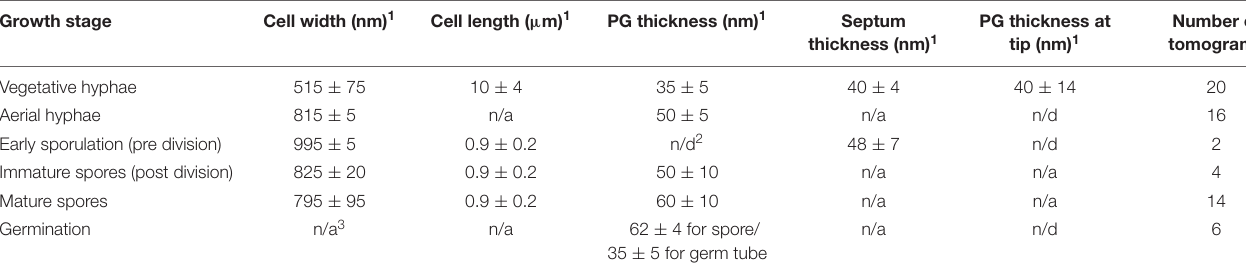
FIGURE 2 | Cryo-ET of vegetative, sporulating, and germinating Streptomyces . Tomographic slices through S . albus at different growth stages corresponding to (A) vegetative hyphae, (B) aerial hyphae formation during early sporulation, (C) septa formation during early sporulation, (D) spore maturation, (E) release of mature spores, and (F) germination. Cytoplasmic membrane (CM) is shown in red. Vegetative peptidoglycan (PG) and spore wall (SW) are shown in green. Rodlet ultrastructure and spore coat are shown in pink and dark purple, respectively. Each tomographic slice is 20-nm thick. Scale bar = 200 nm. TABLE 1 | Cell dimensions, PG thickness, and septum thickness at each developmental